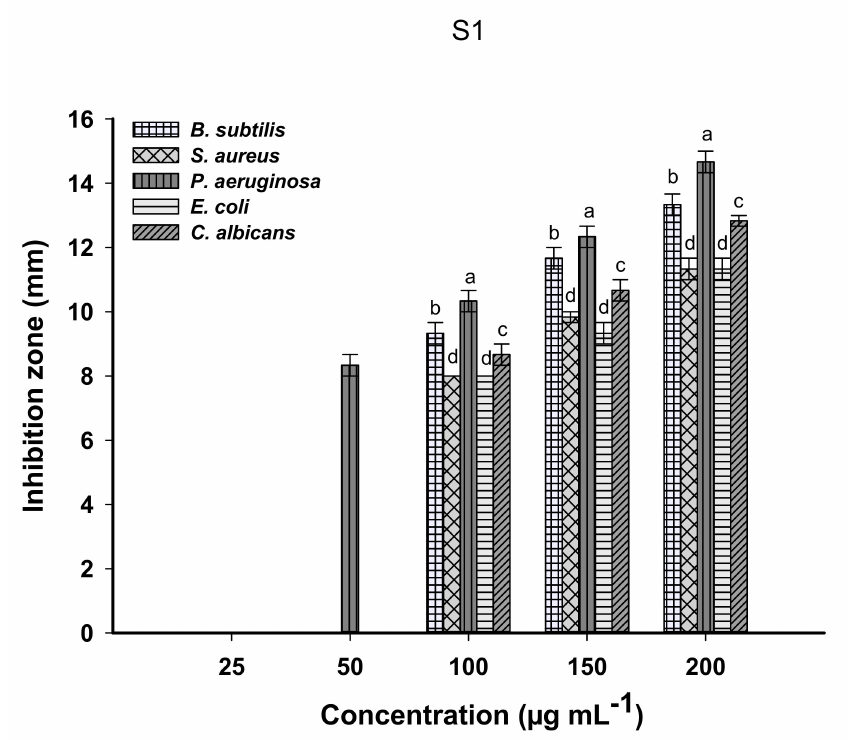
Figure 8. The antimicrobial activity of different concentrations of biogenically synthesized MgO-NPs against Staphylococcus aureus , Bacillus subtilis , Pseudomonas aeruginosa , and Escherichia coli , and Candida albicans . Different letters (a, b, c, and d) on bars at the same concertation refer that the mean values are significantly different ( p ≤ 0.05) ( n =